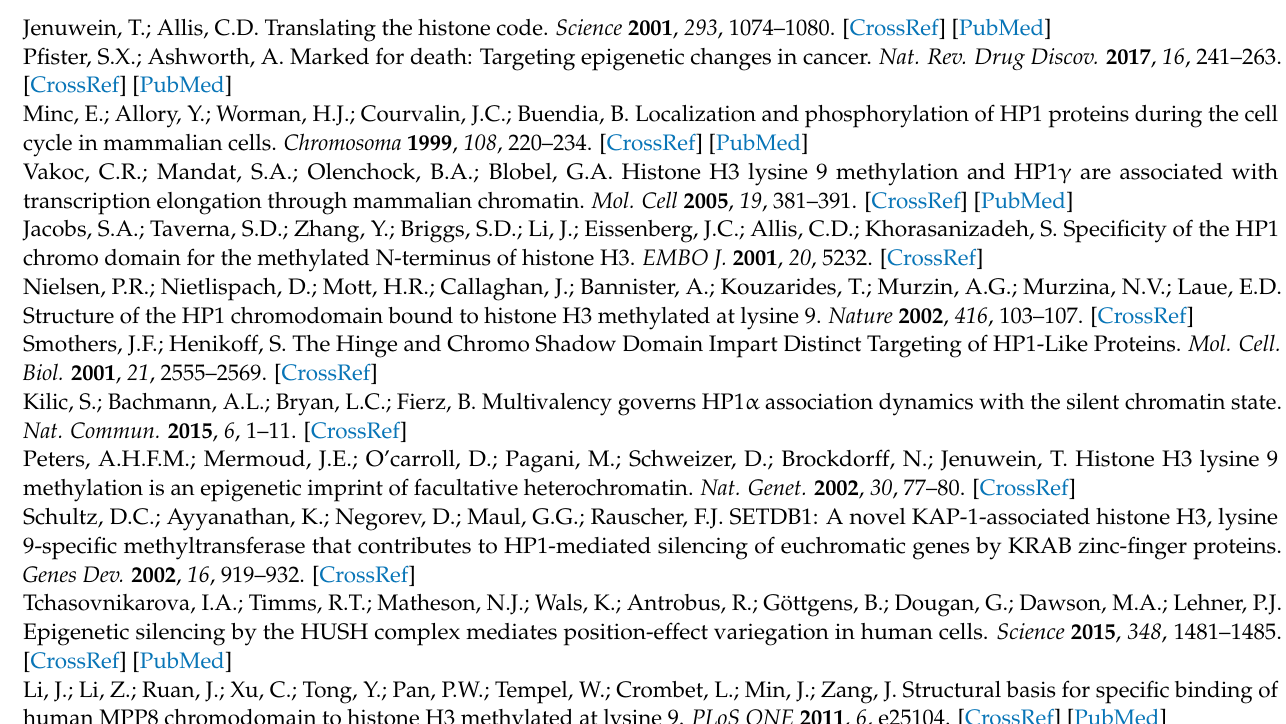
not complete gene silencing; Figure S11: Validation of Hdgfrp2 -targeted CRISPR/Cas9 knockout in CiA:293T cells; Figure S12: Flow cytometry gating used to compare HRP2WT and HRP2KO GFP+ populations over time; Figure S13: Validation of Hdgfrp2 -targeted CRISPR/Cas9 knockout in MDA- MB-231 cells; Figure S14: HRP2 knockout induces changes in MDA-MB-231 cellular morphology, including increased size, loss of membrane boundaries, enlarged nuclei, and increased granularity; Table S1: shRNA Sequences; Table S2: RNA qRT-PCR Primer Sequences; Table S3: ChIP Primer